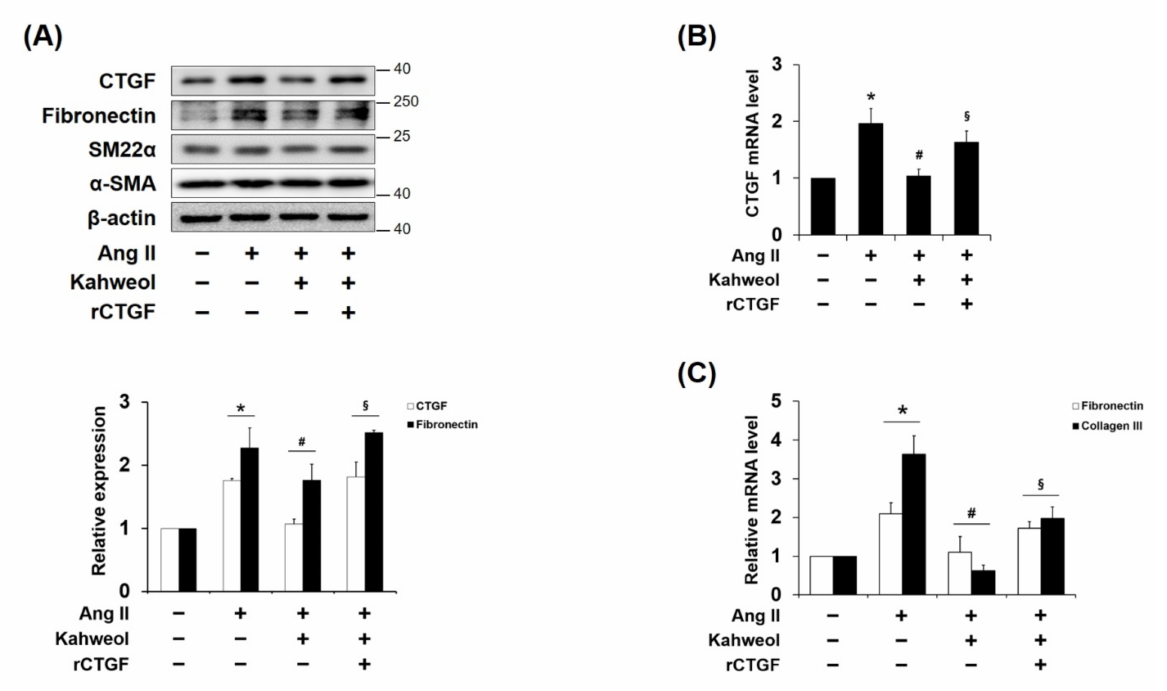
Figure 2. Kahweol effect on phenotype markers in Ang II-stimulated VSMCs. Cells were pretreated with rCTGF (50 ng/mL) and kahweol (10 µ M) at one hour intervals and then stimulated with Ang II for 24 h. ( A ) Protein levels of CTGF, fibronectin, SM22 α , α -SMA, and β -actin were determined by Western blotting with specific antibodies. Bar graphs present the densitometric quantification of the Western blot bands. ( B , C ) mRNA levels of CTGF, fibronectin, and collagen III were determined by qRT-PCR analysis. Results are representative of three independent experiments. *, p < 0.05 vs. untreated control; #, p < 0.05 vs. Ang II group; §, p < 0.05 vs. kahweol + Ang II treated